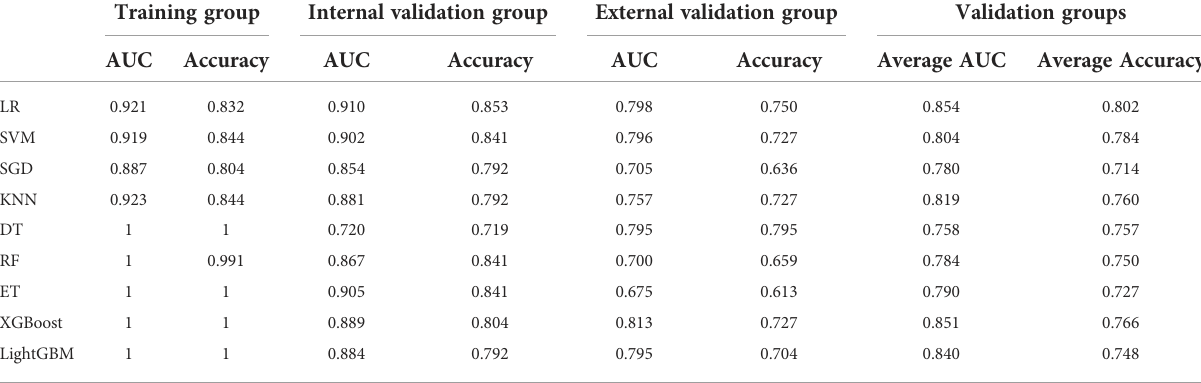
TABLE 3 The performance of various machine learning algorithms.